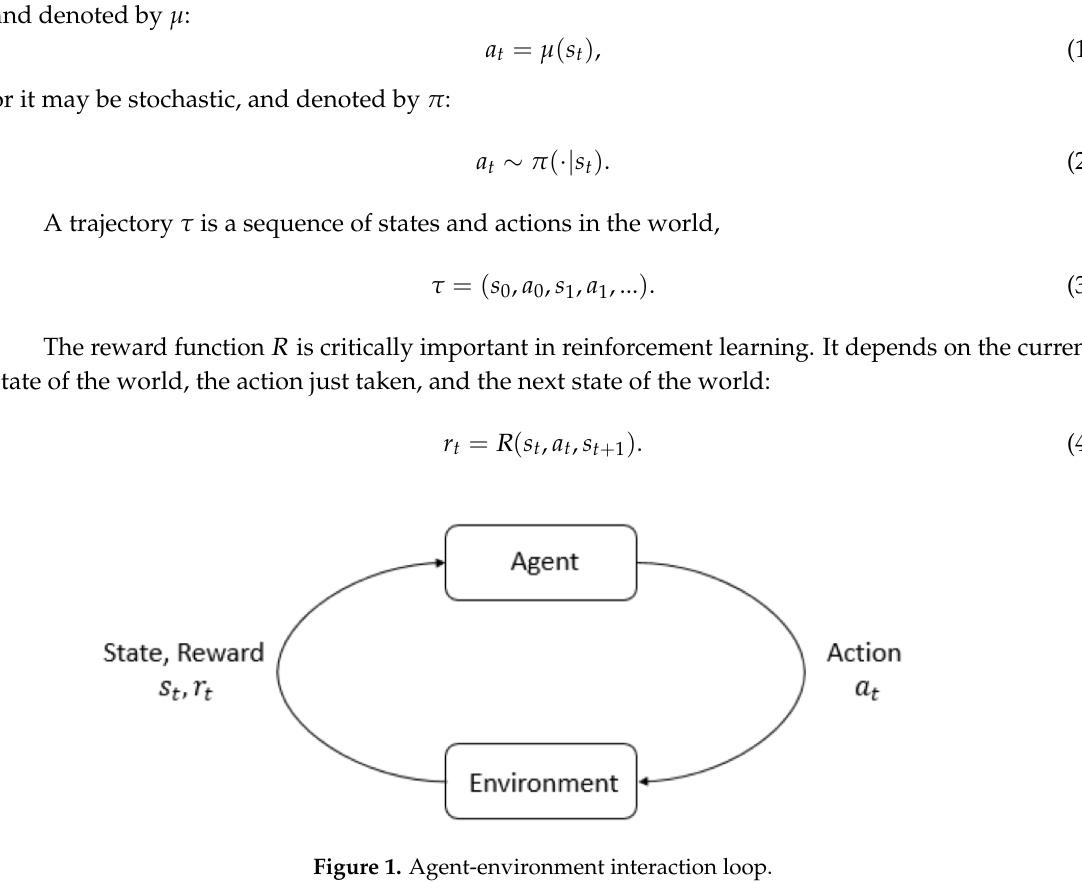
Figure 1. Agent-environment interaction